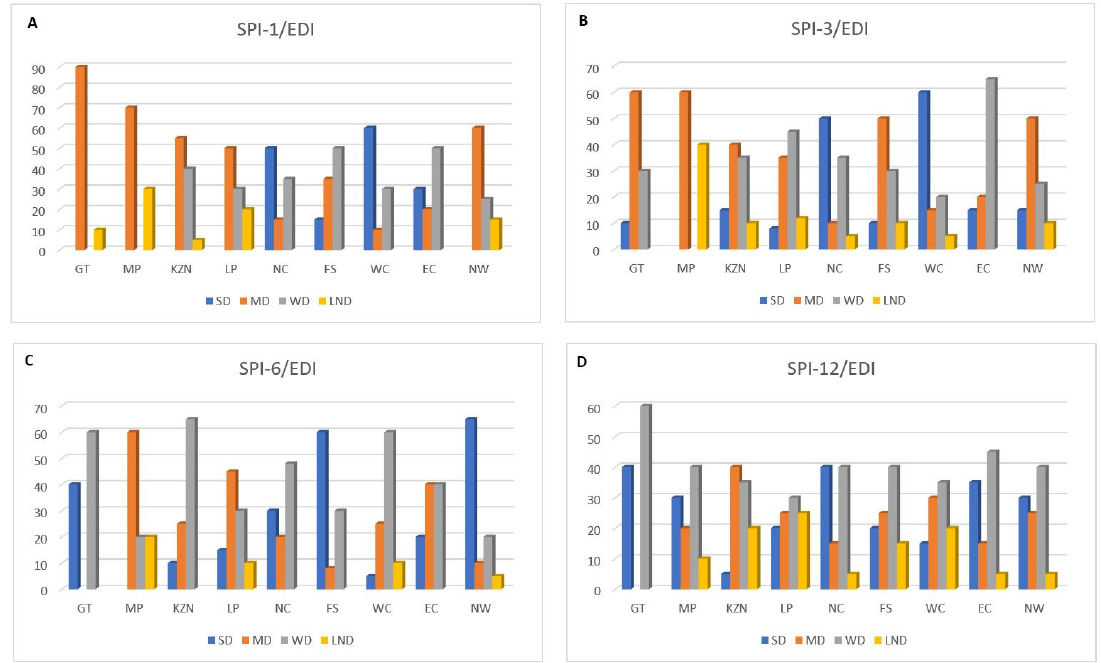
Figure 10. Percentage of the periodogram dissimilarity measure for drought severity in South Africa. ( A ) SPI-1/EDI; ( B ) SPI-3/EDI; ( C ) SPI-6/EDI; and ( D ) SPI-12/EDI. Strong Dissimilarity (SD), Moderate Dissimilarity (MD), Weak Dissimilarity (WD), Little or No Dissimilarity (LND).